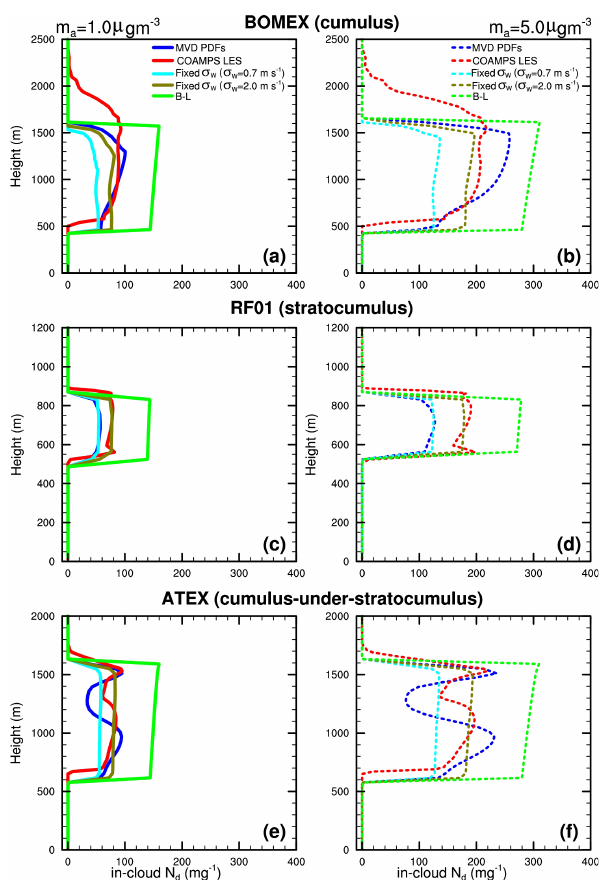
Fig. 3. Profiles of in-cloud droplet number concentrations ( N d ) at sulfate concentrations ( m a ) of 1.0µgm − 3 in (a) , (c) , and (e) , and of 5.0µgm − 3 in (b) , (d) , and (f) , averaged over the last 3h for BOMEX in (a) and (b), last 2h for RF01 in (c) and (d), and last 5h for ATEX in (e) and (f).